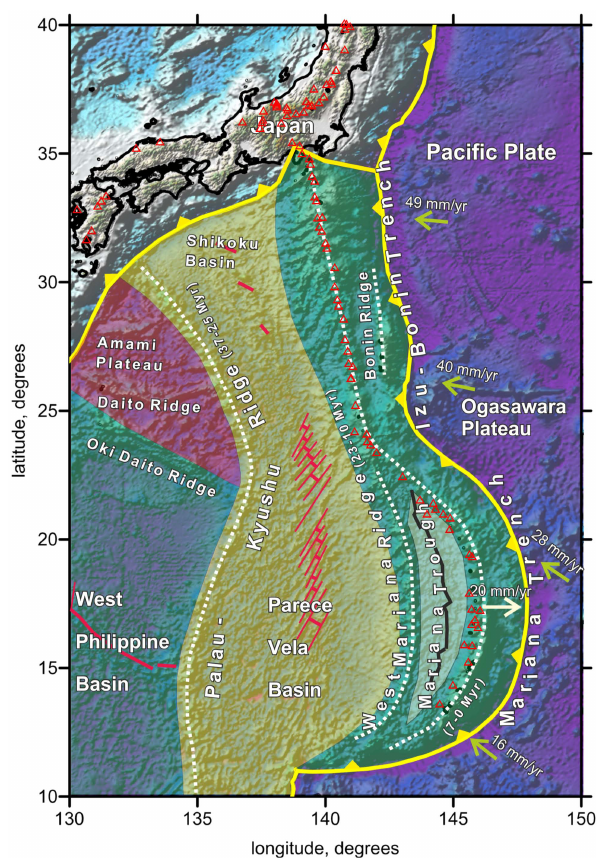
Fig. 1. The main geographic and tectonic units of the studied re- gion. Background is map of topography/bathymetry. The colours indicate the regions of the oceanic crust of different ages according to Peive, (1980): Pre-Cretaceous (green), Pre-Mesozoic (red), Pre- Miocene (yellow), Pre-Quaternary age (white), sea floor of Pacific Ocean, Pre-Triassic (blue). White dotted lines depict arcs (ancient and present) (Peive, 1980). Names and ages of arcs are indicated. Arrows with numbers present the displacement rates in respect to Philippine plate (DeMets et al., 2010). The red triangles indicate ac- tive volcanoes (including submarine and hydrothermal volcanoes) (Taylor and Nesbitt, 1998; Baker et al.,